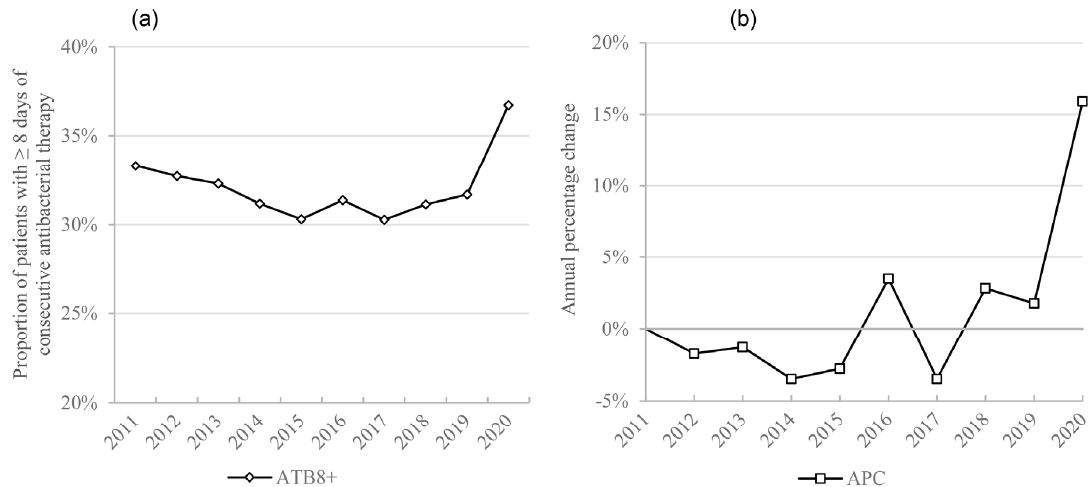
Figure 4. Extended antimicrobial therapy: ( a ) March–May average proportion of patients with ≥ 8 days of antibacterial therapy (ATB8+); ( b ) annual percentage change of March–May average ATB8+.